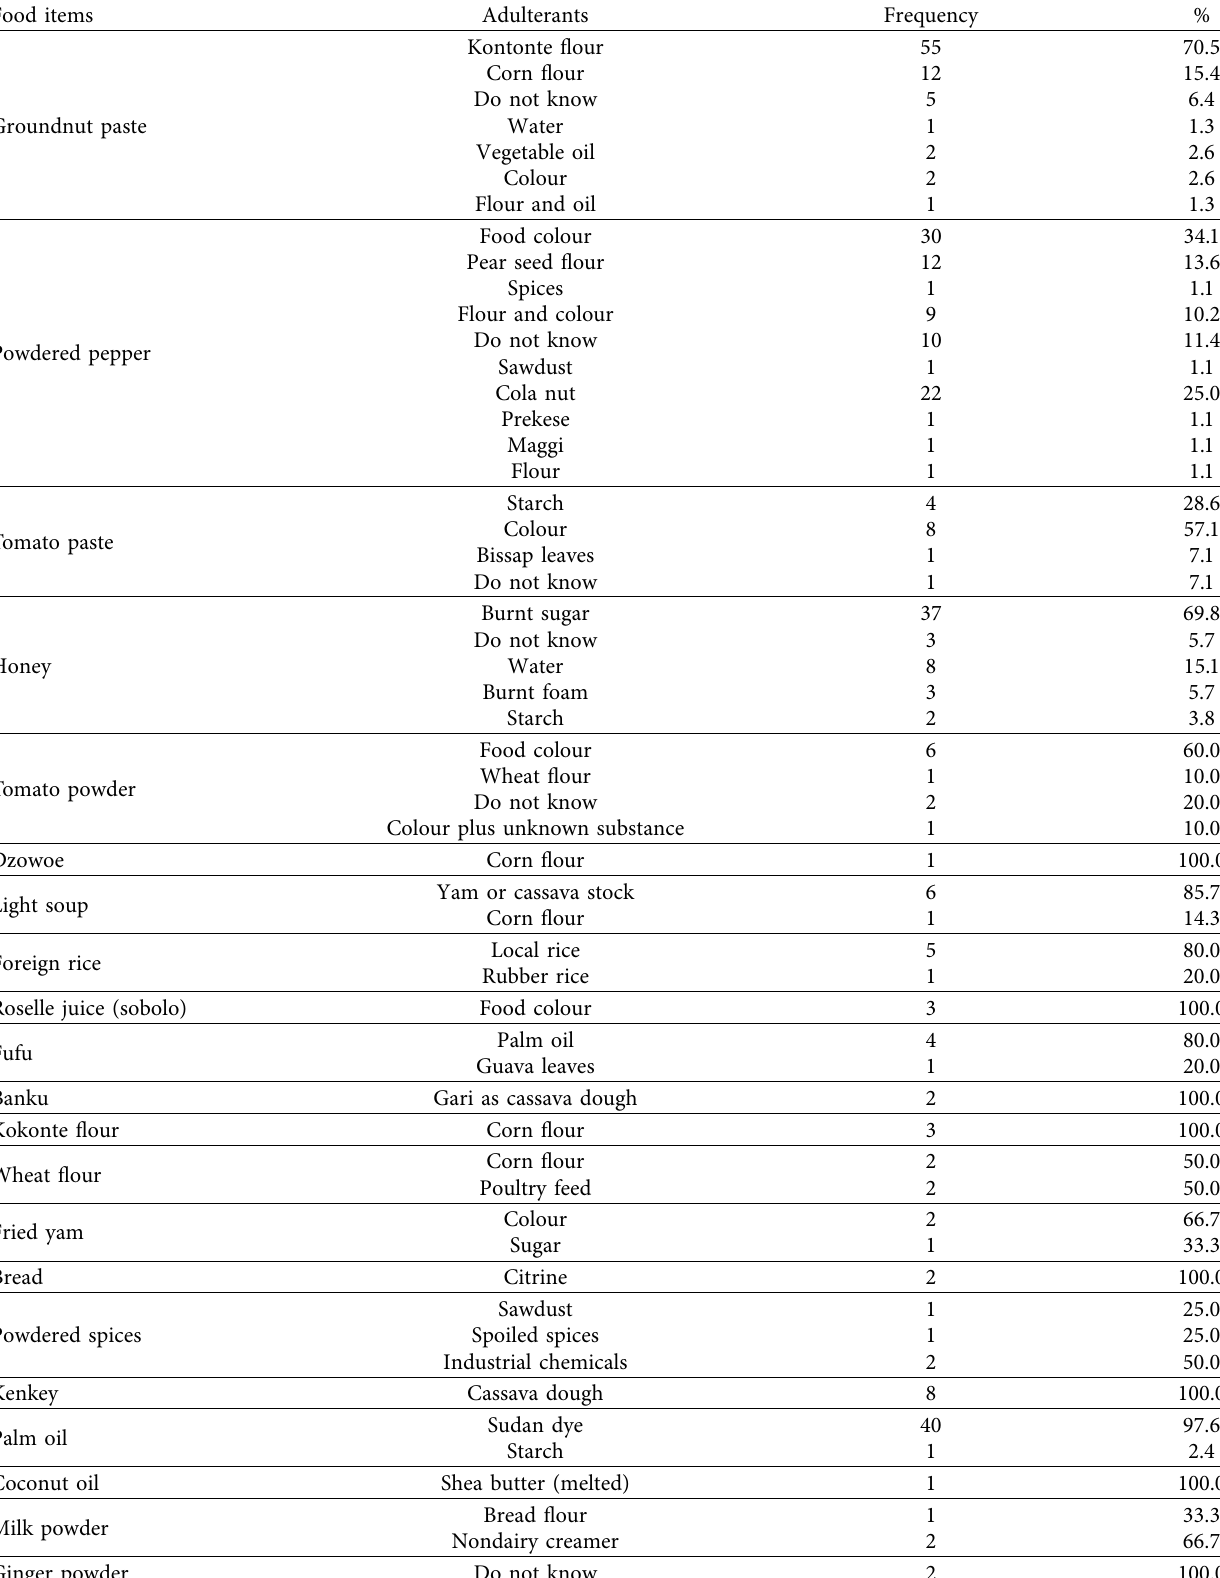
Table 5: Common adulterants in food items reported by the